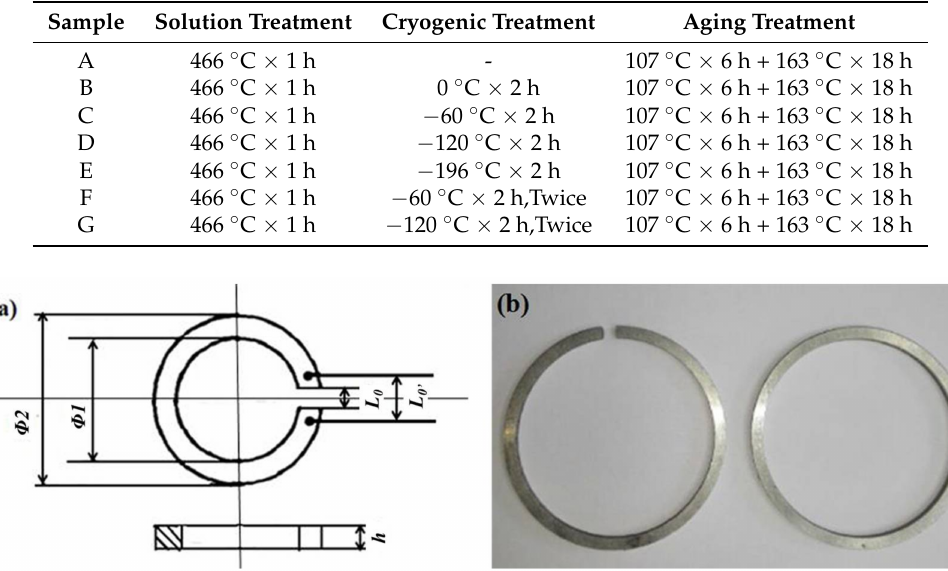
Figure 1. Open ring sample: ( a ) two-dimensional schematic diagram, ( b ) ring sample photograph ( Φ 1 = 50 ± 0.1 mm, Φ 2 = 56 ± 0.1 mm, h = ± 0.1 mm, L 0 (cid:48) = 5 ± 0.1 mm, L 0 = 3 ± 0.1